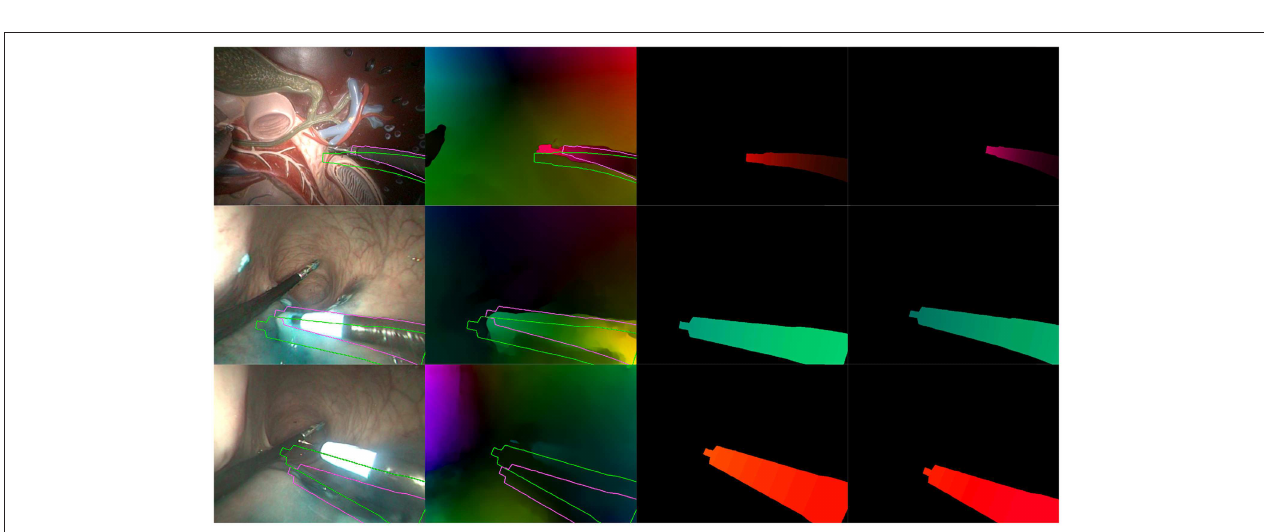
FIGURE 8 | Examples of correct results obtained with our optimization algorithm. First two rows feature examples from the in vivo dataset, while the last two rows feature examples from the benchtop dataset. The columns are organized as follows, from left to right: Endoscopic image, with contours of the mask M before (green) and after (purple) optimization; Optical flow image ˆ F with the same superimposed contours; Virtual optical flow image F v before optimization; Virtual optical flow image F v after optimization.